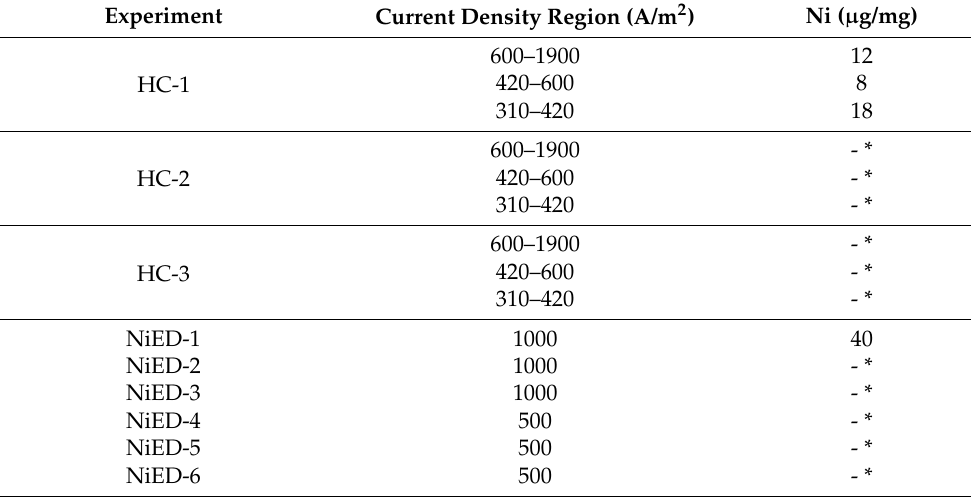
Table 10. Summary of Ni co-electrodeposition experiments. Ni concentration in the solid cathode, based on total dissolution to aqua regia and analysis by flame-AAS. * Solution analysis results below the detection limit (<0.2 µ